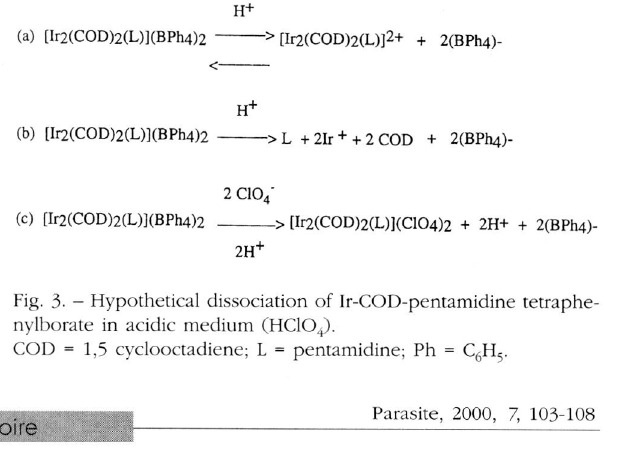
Fig. 3- - Hypothetical dissociation of Ir-COD-pentamidine tetraphe­ nylborate in acidic medium (HC10 COD = 1,5 cyclooctadiene; L = pentamidine; Ph = C Mémoire